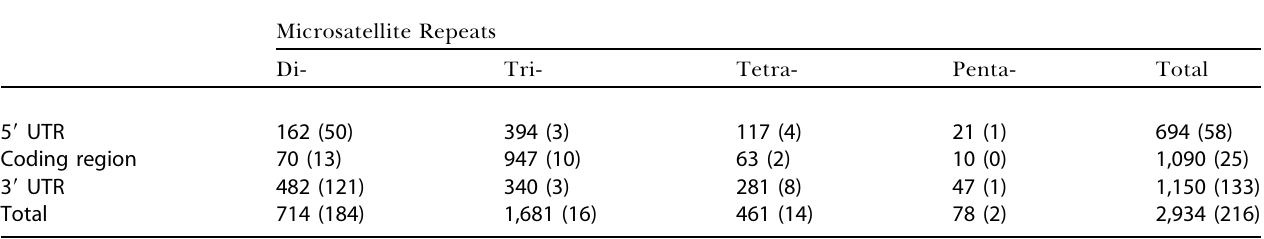
Table 6. The Numbers of Microsatellite Repeat Motifs That Occurred in the Representative